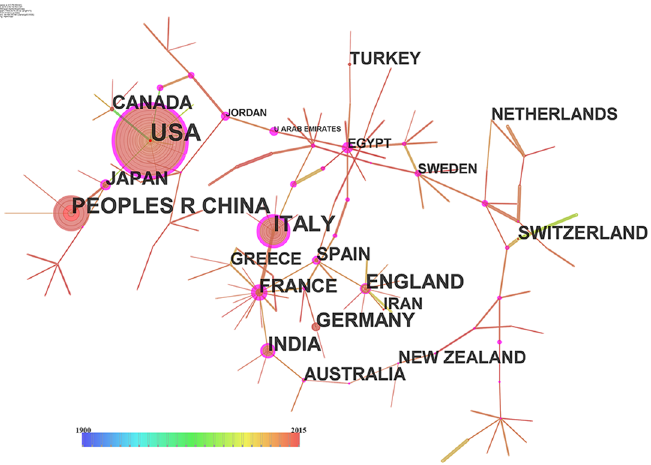
Fig 2. A collaboration network of natural disasters of 160 nodes and 157 links. Circular nodes represent countries/ regions. The size of a circle is in proportion to the number of literatures of the country. The colors of rings of a circle are corresponding to the year. The purple rims of circles represent the high betweenness